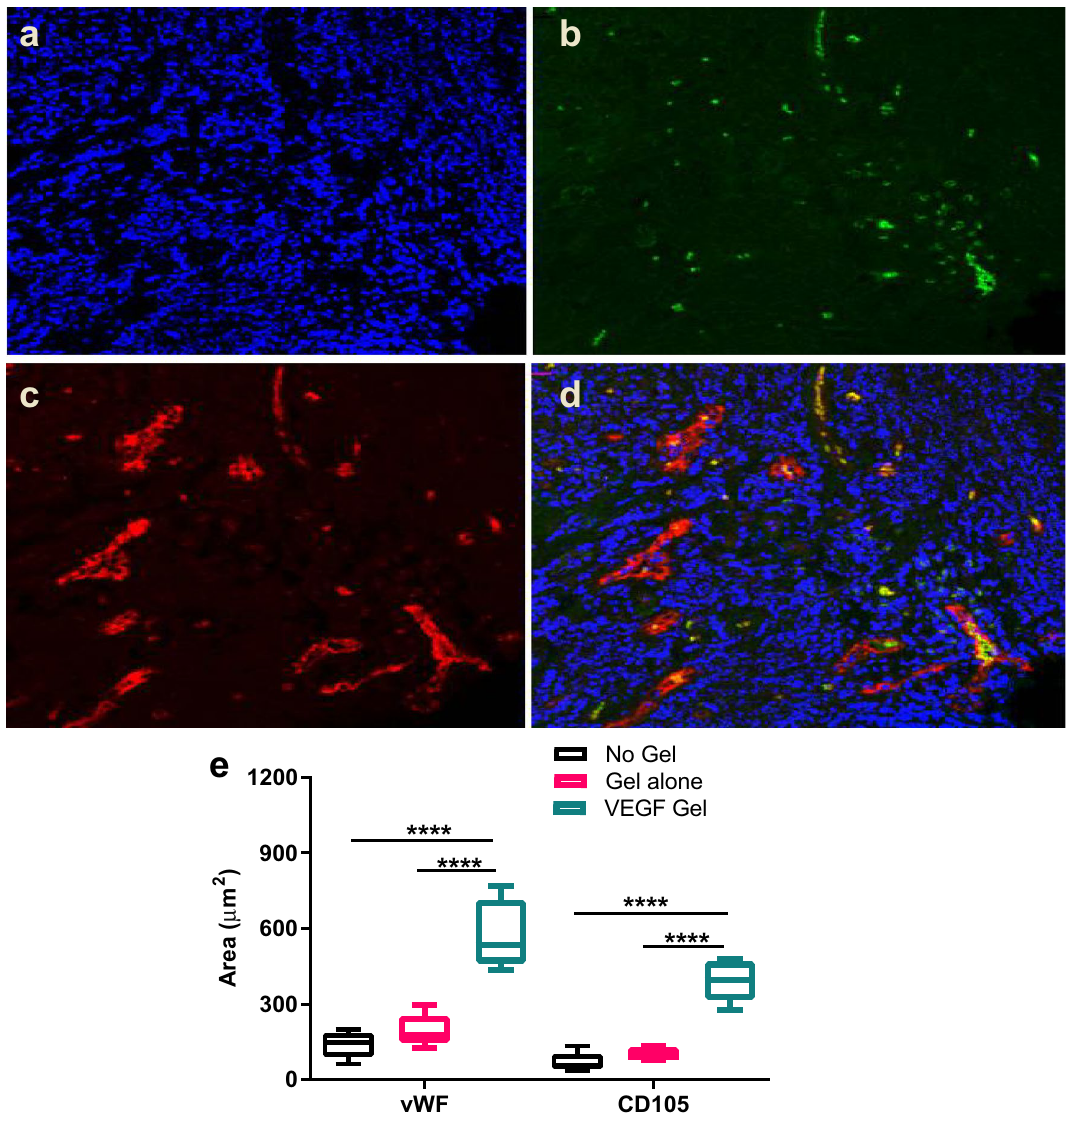
Figure 5. Representative image from VEGF gel group with double immunofluorescence staining for vascular markers. Nuclear stain DAPI (blue, a ), CD105 (green, b ), vWF (red, c ), and merged photomicrograph ( d ). Quantification of staining ( e ) showed significant difference between VEGF-gel and the other groups in vWF and CD105 expression (****p <